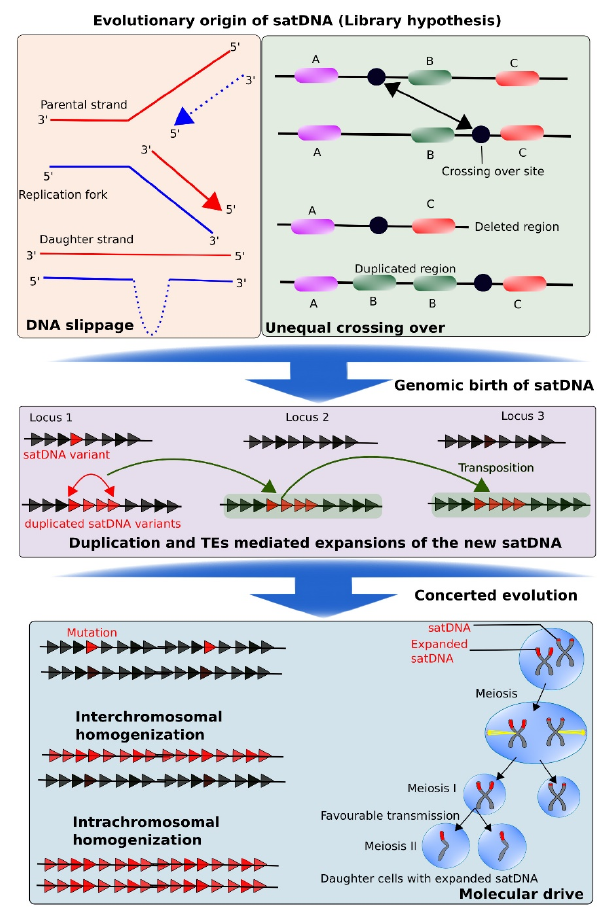
Figure 5. Model of satellite DNA evolution. Genomic birth of satellite DNA can occur as a result of different mechanisms. According to the Library hypothesis, the two main proposed phenomena are DNA replication slippage and unequal crossing over, which can cause mutations and de novo formation of satellite DNA (variants shown as red triangles). The newly formed satellite region can undergo several duplications and subsequent transposition events that expand the new satellite throughout the genome. Transposable elements mediate the spreading of newly evolved satellite repeats to different loci. This is followed by cohesive evolution of the genomic region to homogenize the entire array through selection. Finally, the evolved satellite repeats are established by sexual reproduction. The chromosome region with expanded satellite is inherited preferentially via a molecular mechanism known as “drive”. Two homologs have the same satellite DNA (red) but with a larger centromere, and one homolog with expanded satellites is attracted by spindle fibers and driven to the daughter